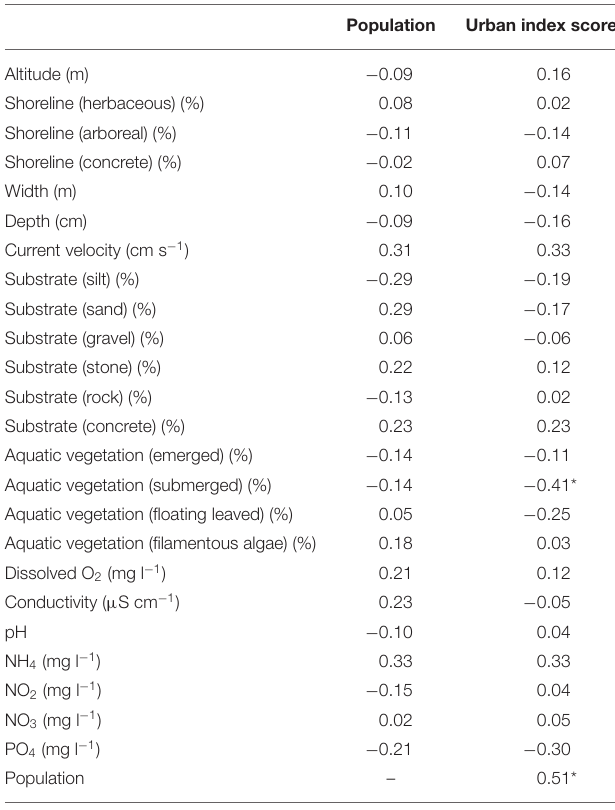
TABLE 1 | Spearman rank correlation values between the urbanization and local habitat variables.